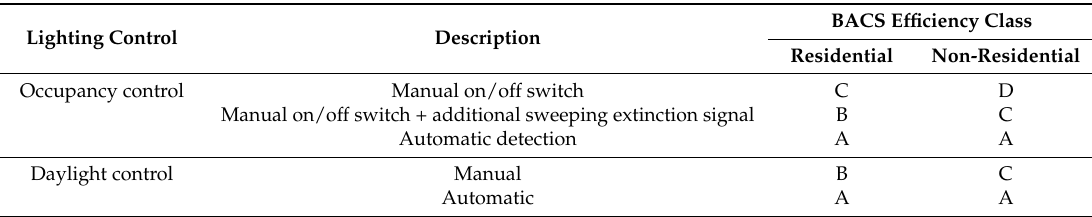
Table 1. The specific BACS control and TBM functions for lighting [39].